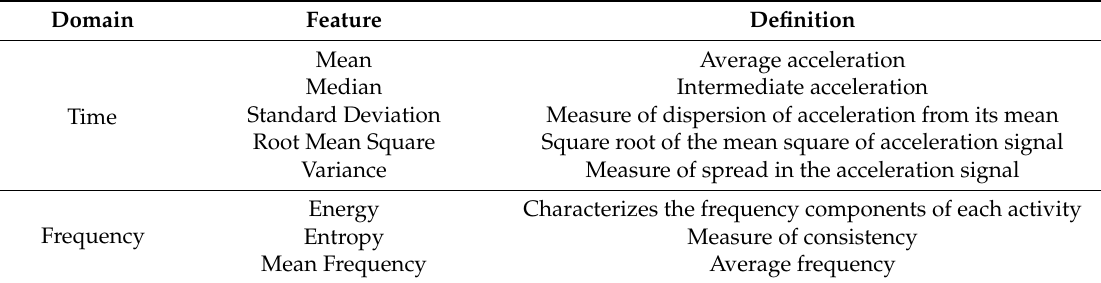
Table 2. Summary of the features that have been extracted, per time window.